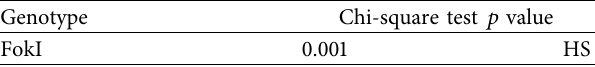
Table 5: Significance of association of rs2228570 with the caries status.